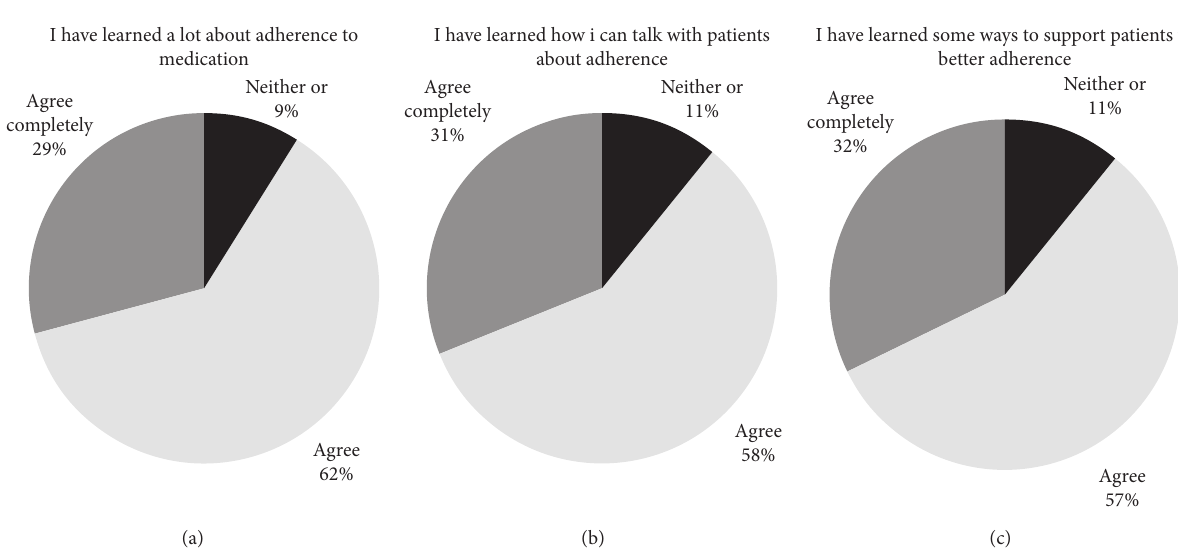
Figure 3: Presenting the participants’ self-reported learning outcome of the